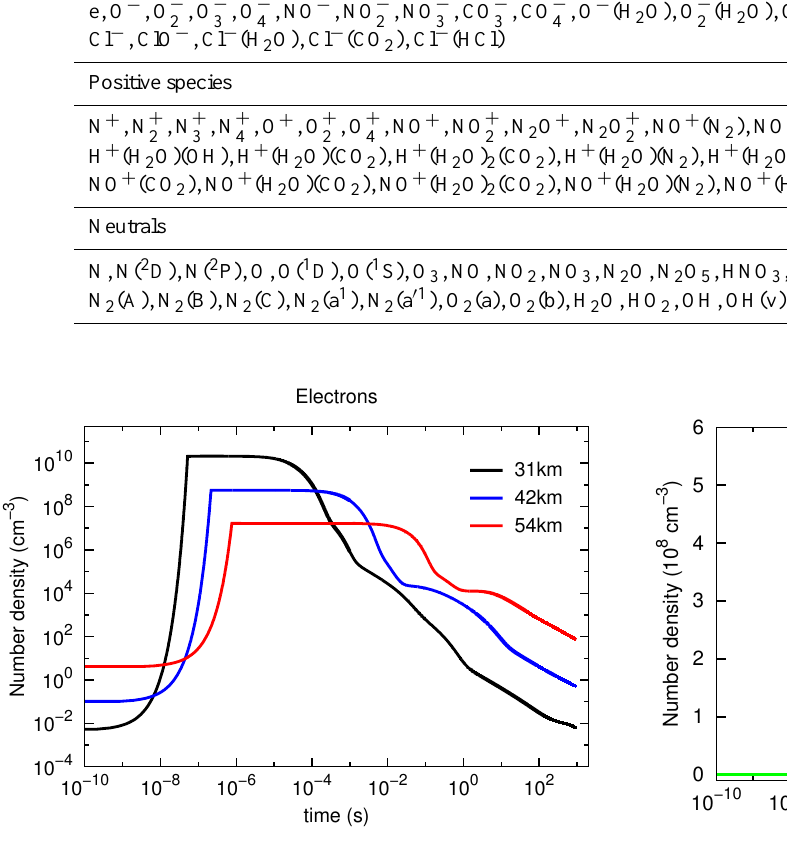
Fig. 1. Modelled evolution of the electron number density in a day- time sprite streamer at three selected altitudes.